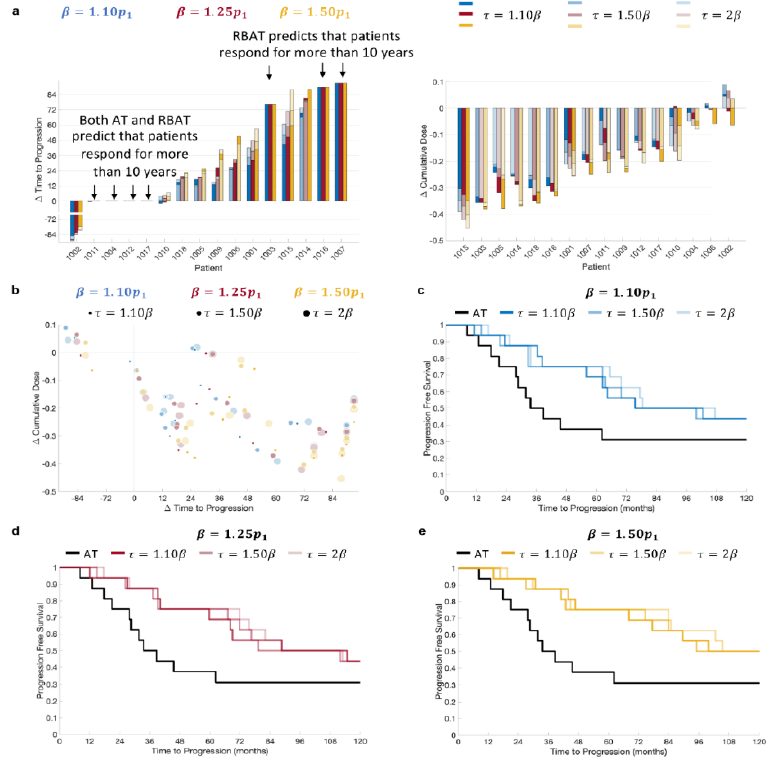
Figure 3. Model simulation change in time to progression and cumulative dose comparisons. ( a ) Comparison of patient-specific (left) change in time to progression and (right) change in cumulative dose for β = ( 1.10 p 1 ,1.25 p 1 , 1.50 p 1 ) and τ = ( 1.10 β , 1.50 β , 2 β ) . ( b ) Change in time to progression versus change in cumulative dose. Kaplan–Meier plots for ( c ) β = 1.10 p 1 , ( d ) β = 1.25 p 1 , and ( e ) β = 1.50 p 1 with τ = ( 1.10 β , 1.50 β , 2 β )